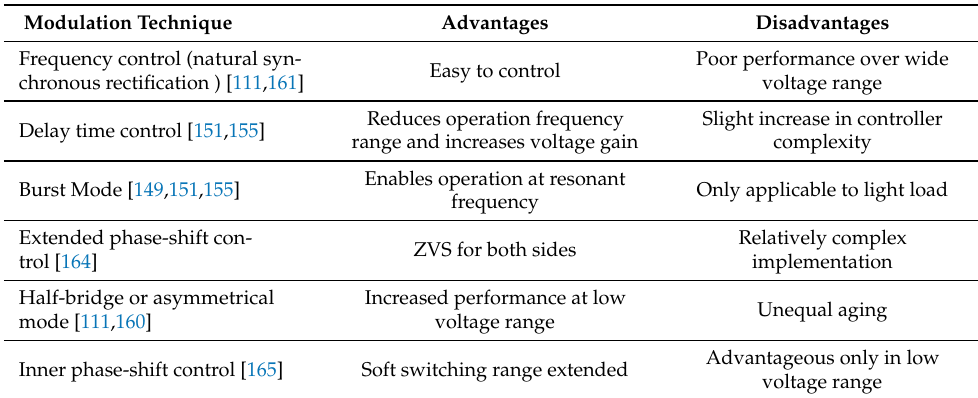
Table 11. Summary of CLLC modulation